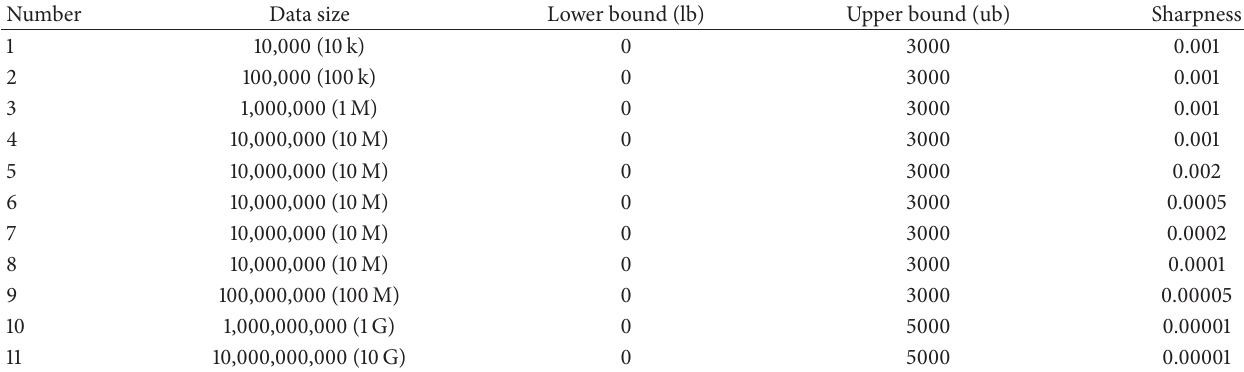
Table 1: Parameters for synthetic